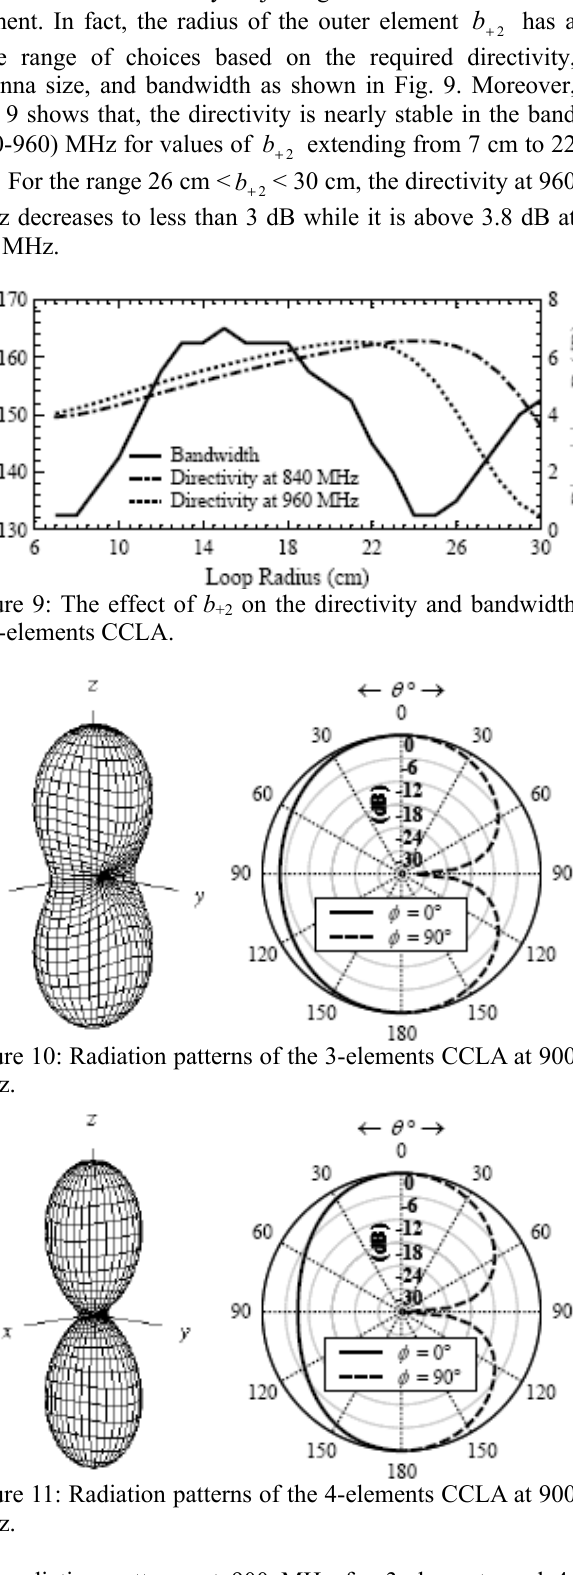
Figure 11: Radiation patterns of the 4-elements CCLA at 900 MHz.